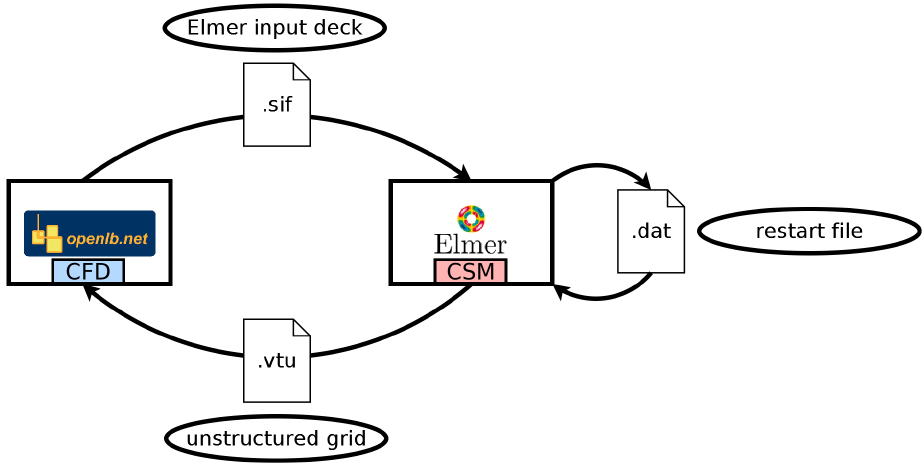
Figure 3. Fluid–structure interaction workflow using OpenLB and